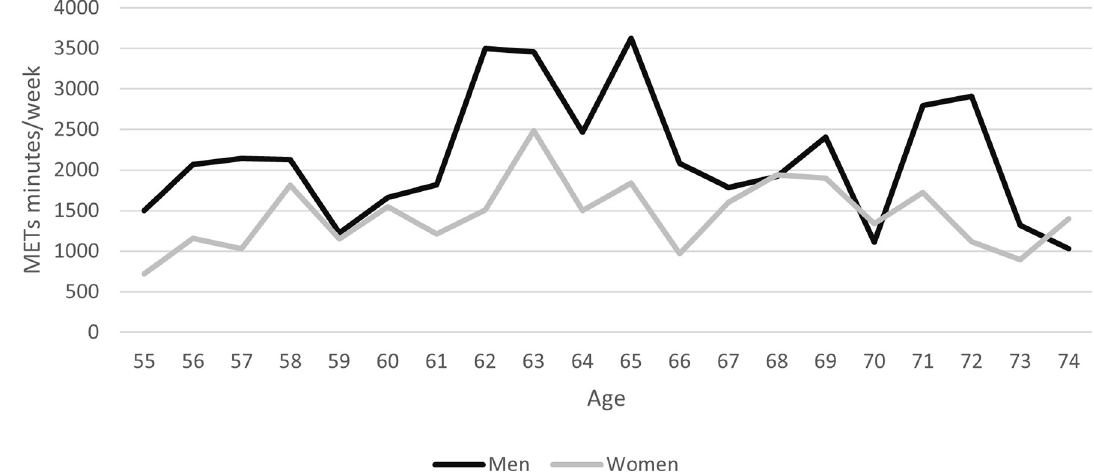
Fig 1. Energy expenditure in METs minutes/week based on the cumulation of PA (sports and leisure physical activities, active transport, domestic physical activities) by gender.